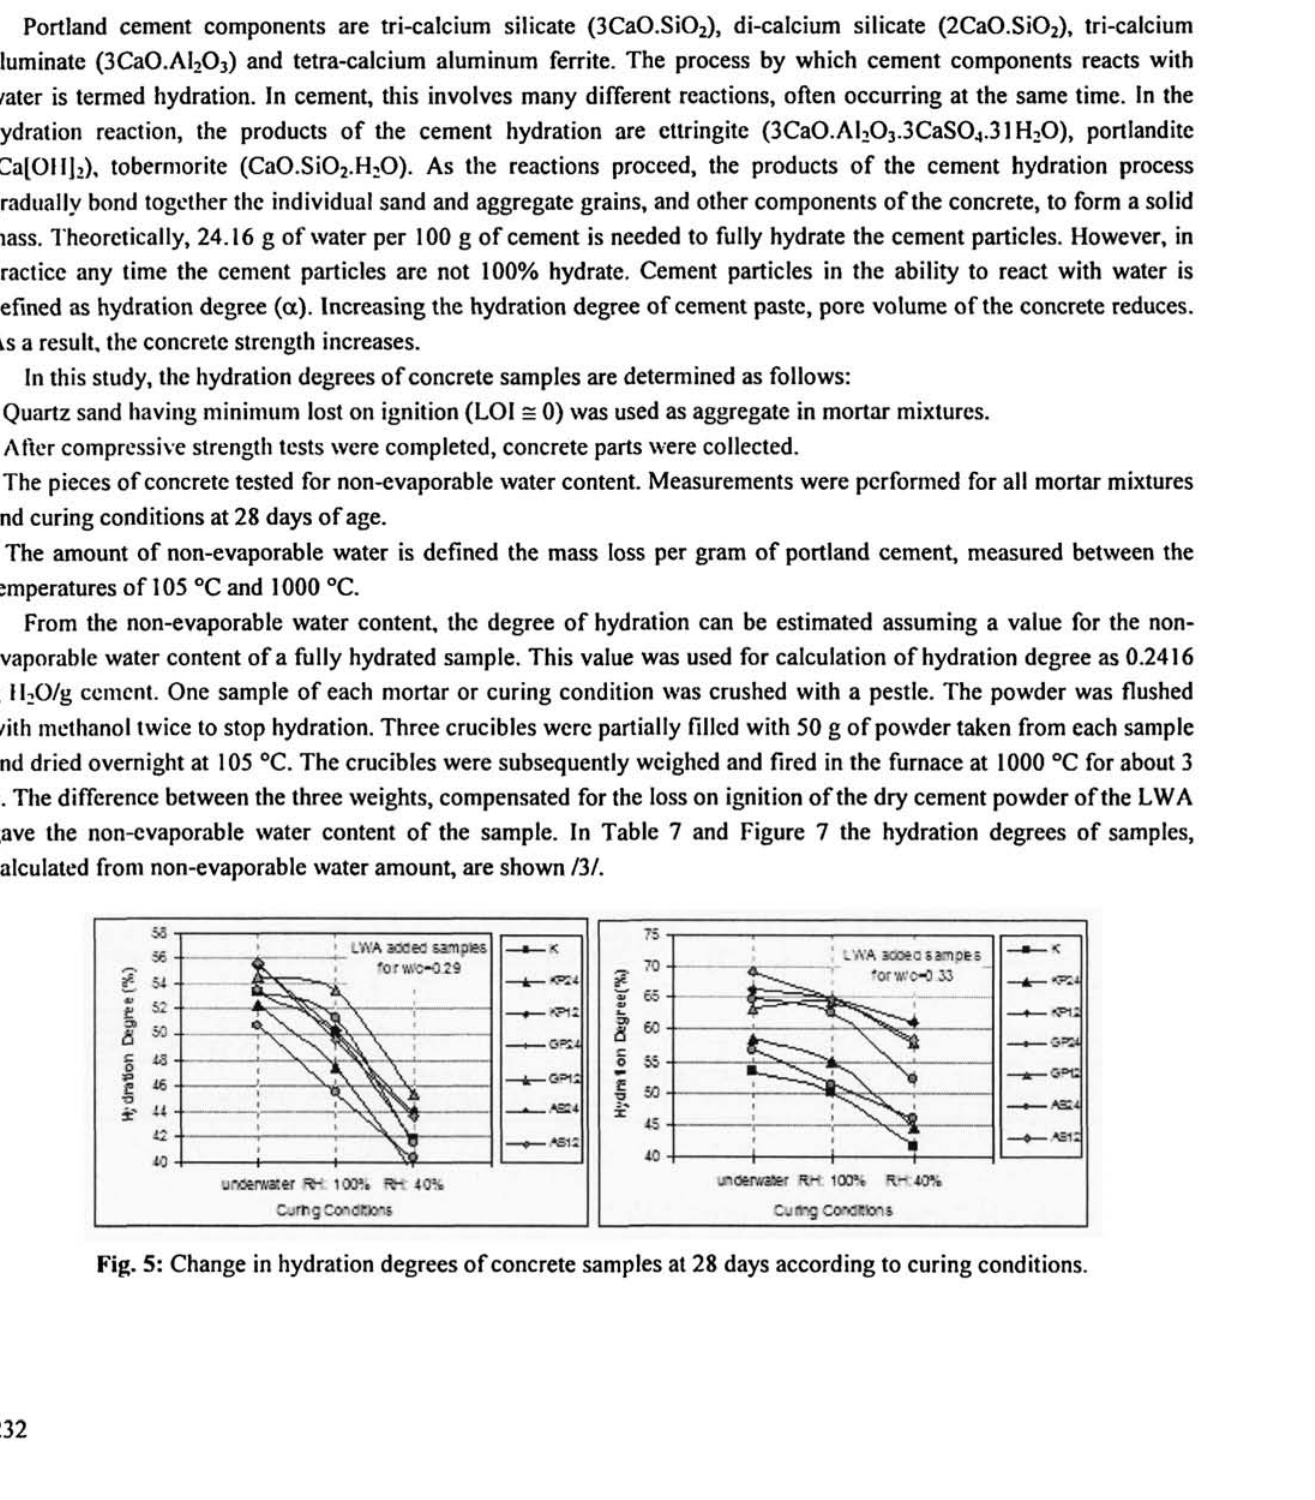
Fig. 5: Change in hydration degrees of concrete samples at 28 days according to curing